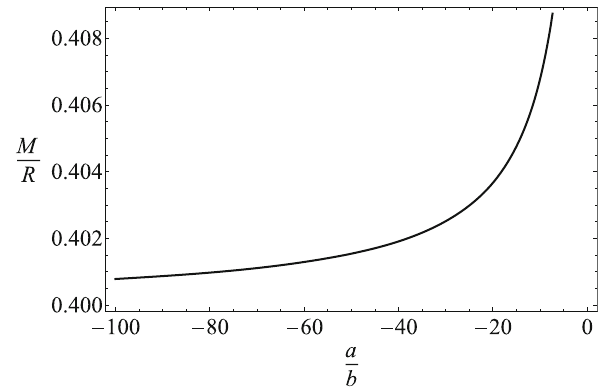
Fig. 2 Upper bound on M / R plotted against the anisotropic parameter a /